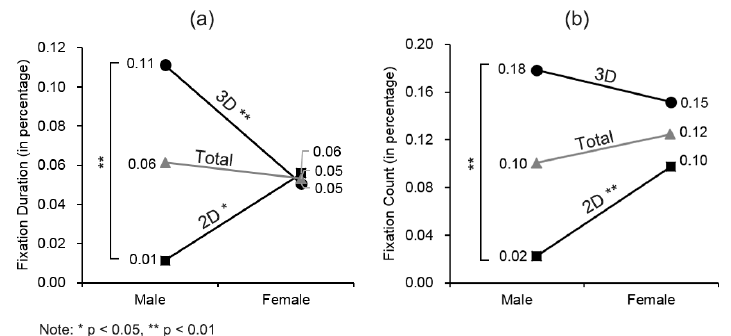
Figure 6. Visual attention on landmarks: ( a ) fixation duration; and ( b ) fixation count.